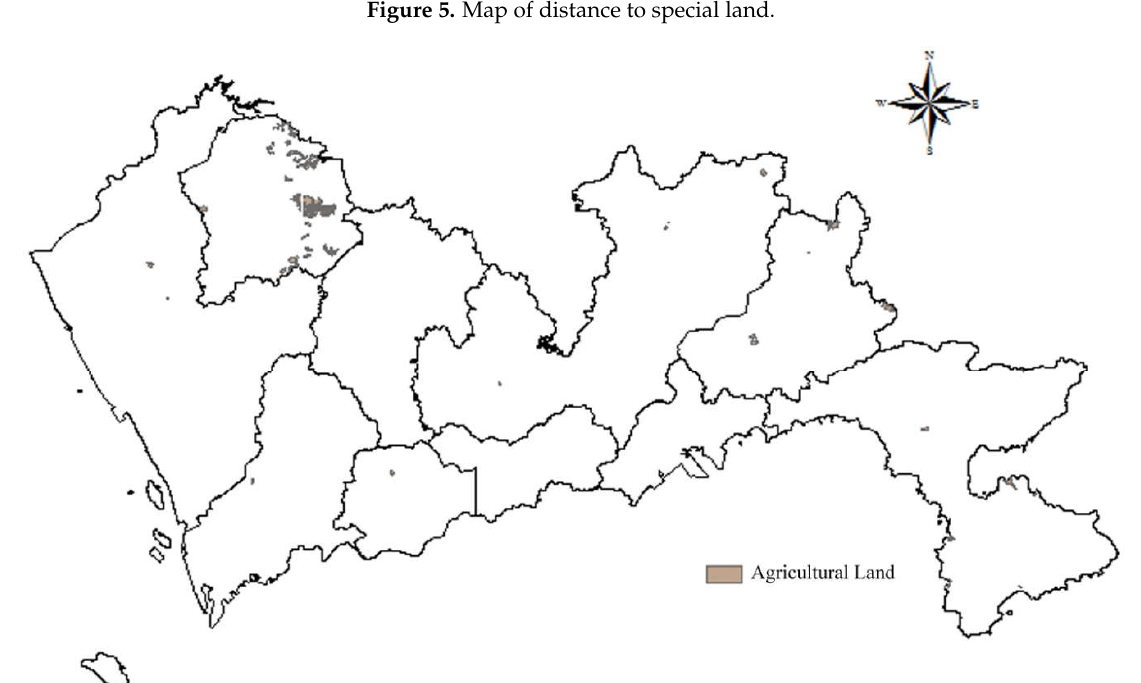
Figure 5. Map of distance to special land.